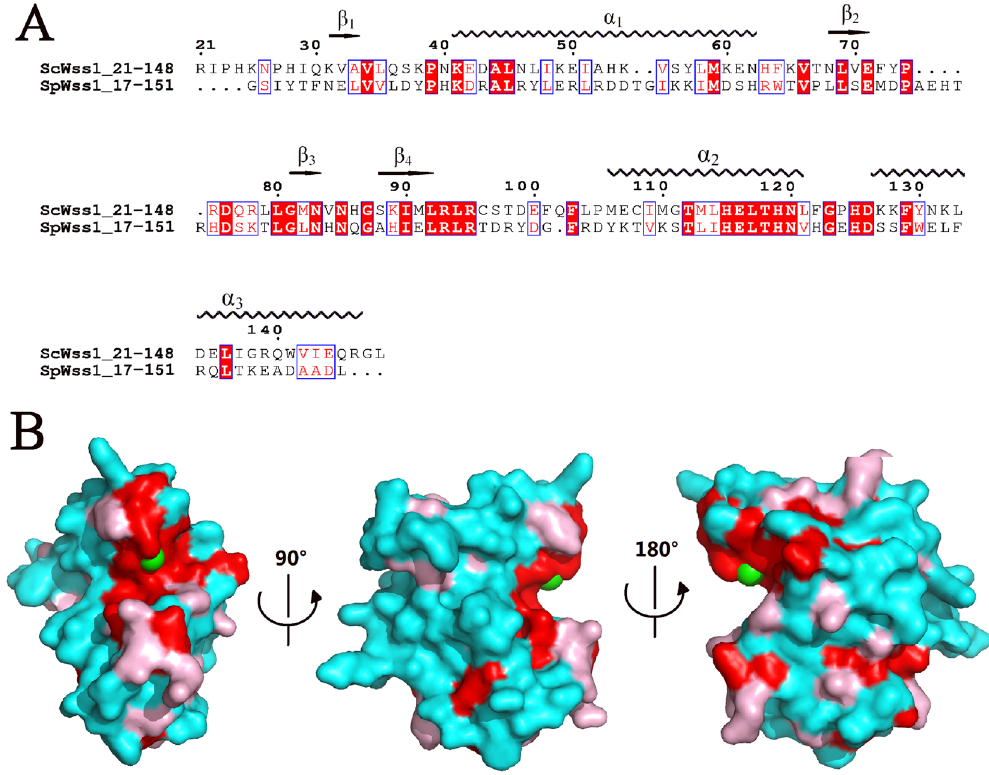
Figure 4. ( A ) Structure based sequence alignment between the protease domain from SpWss1 (PDB: 5JIG) and ScWss1 (PDB: 5XBN), performed using Clustalw (version 2.0) and Espript 3 26 . The conserved residues are boxed in blue. Identical conserved and low conserved residues are highlighted in red background and red letters, respectively. ( B ) Conserved residues are mapped onto the ScWss1 21-148 surface. Identical conserved residues, low conserved residues, and the most variable residues are shown in red, pink, and cyan, respectively. The zinc ion is shown in green